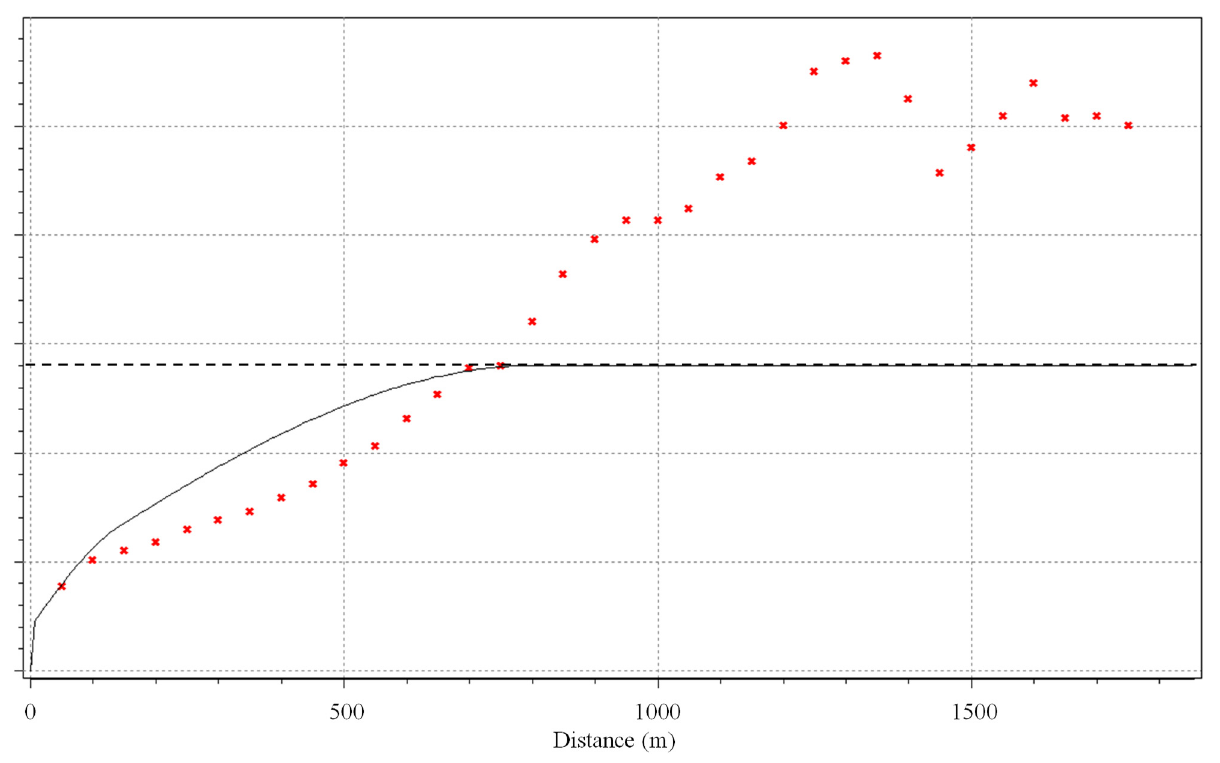
Figure 7. The 3D omnidirectional Spherical model variogram of Zn grade with range of 800 m. The horizontal dash line is the variance of Zn grade (i.e., 0.014% 2 ). Red cross point is experimental variogram while the black line is the fitting model.